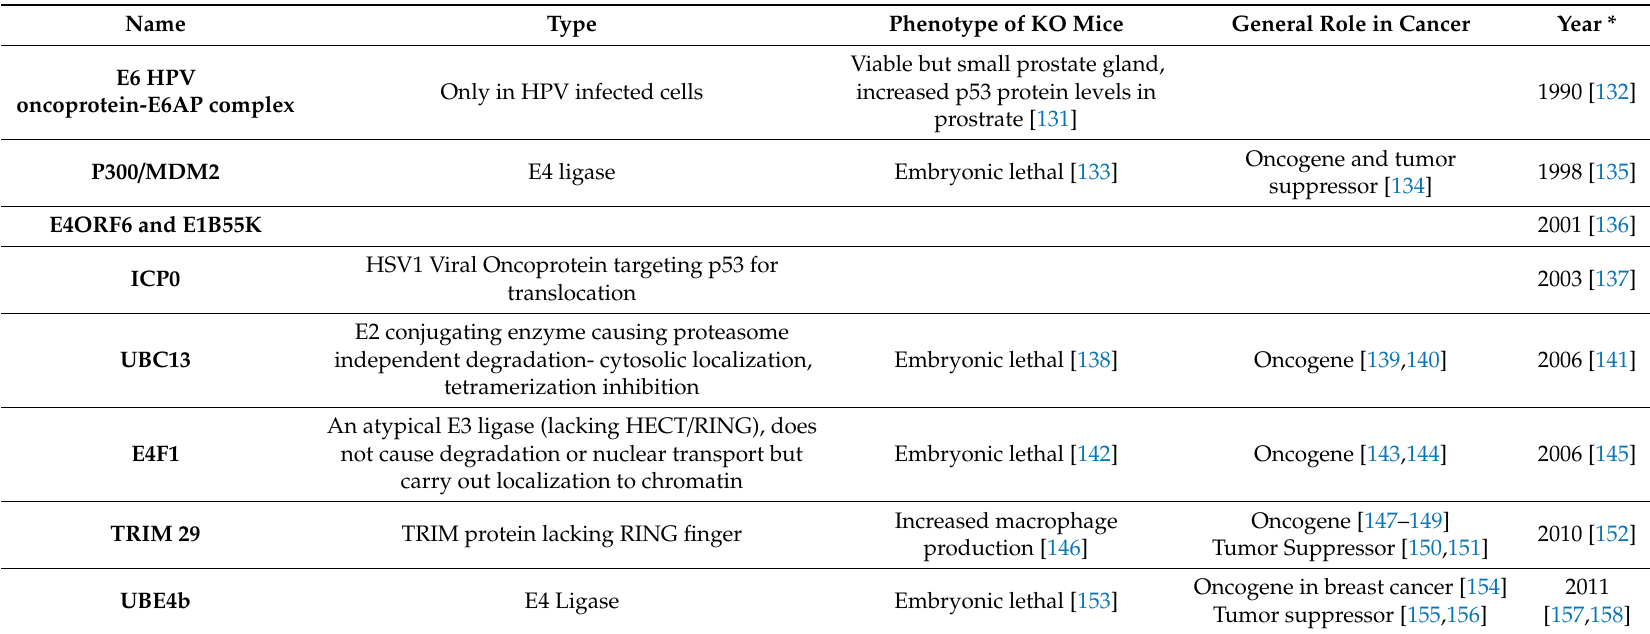
Table 2. Non-E3 ligases that Promote the Degradation of p53